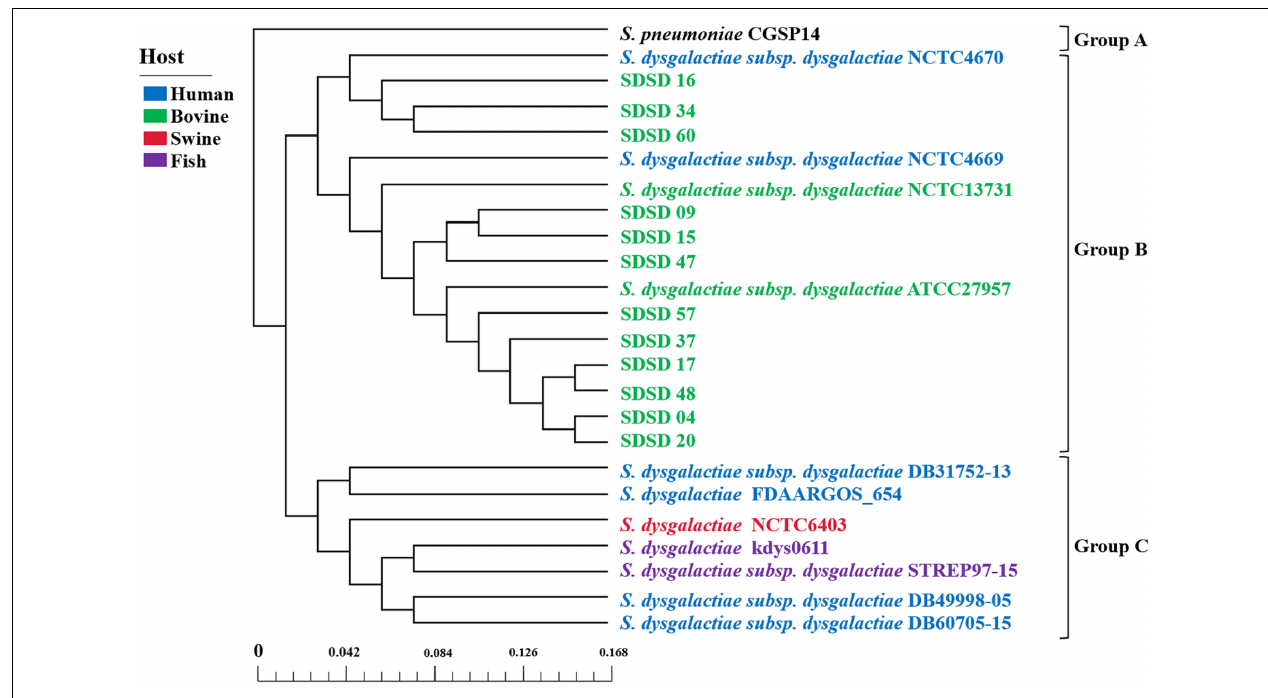
FIGURE 8 | Phylogenetic tree, based on the core genes of 24 Streptococcus genomes, including 12 SDSD genomes obtained from the Illumina sequencing, and 12 Streptococcus genomes obtained from NCBI. Scale bar indicates the base substitution per site. The phylogenetic tree revealed that the 24 Streptococcus genomes were divided into 3 groups. Group A only contained S. pneumoniae CGSP14. Group B harbored all SDSD isolates collected from bovine, including 12 SDSD isolates in this study and 2 SDSD genomes (NCTC13731 and ATCC27957) obtained from NCBI. Group C consisted of S. dysgalactiae strains obtained from humans (DB31752-13, FDAARGOS_654, DB49998-05 and DB60705-15), fish (kdys0611 and STREP97-15) and swine